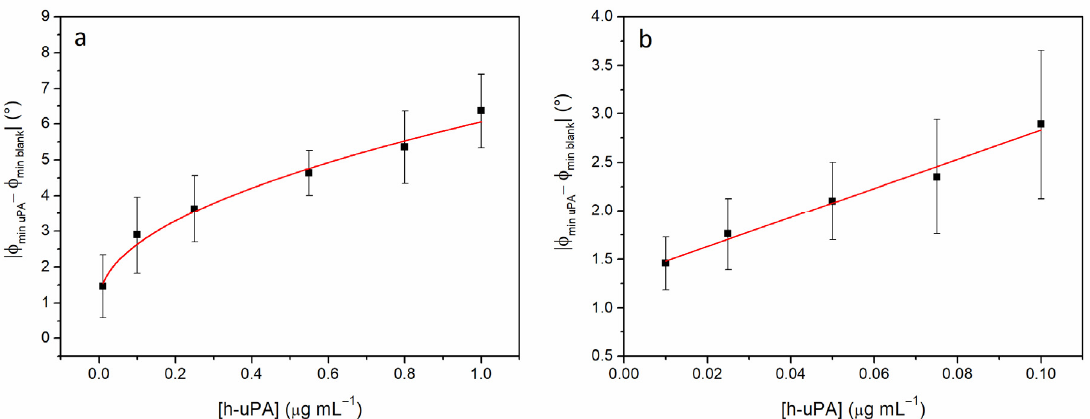
Figure 6. ( a ) Calibration plots in the h-uPA concentration range 0.01–1 µg mL − 1 with data regression obtained with the 4 parameters logistic model and ( b ) in the h-uPA concentration range 0.01–0.1 µg mL − 1 with linear fitting equation (black full line): y = 15 ± 1x + 1.33 ± 0.04. The values presented are the average of triplicate measurements with the associate error calculated as the standard deviation.